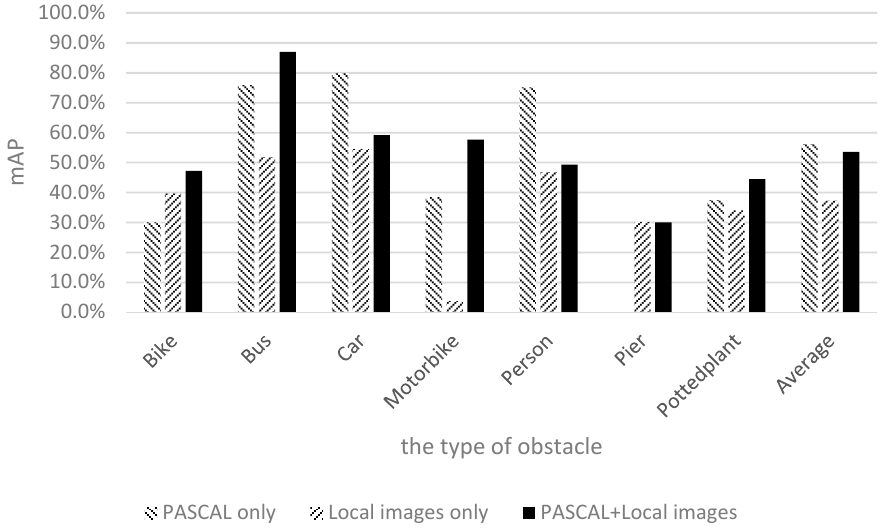
Figure 18. Comparison between Pascal-based, local, and mixed datasets after 40,000 training iterations.